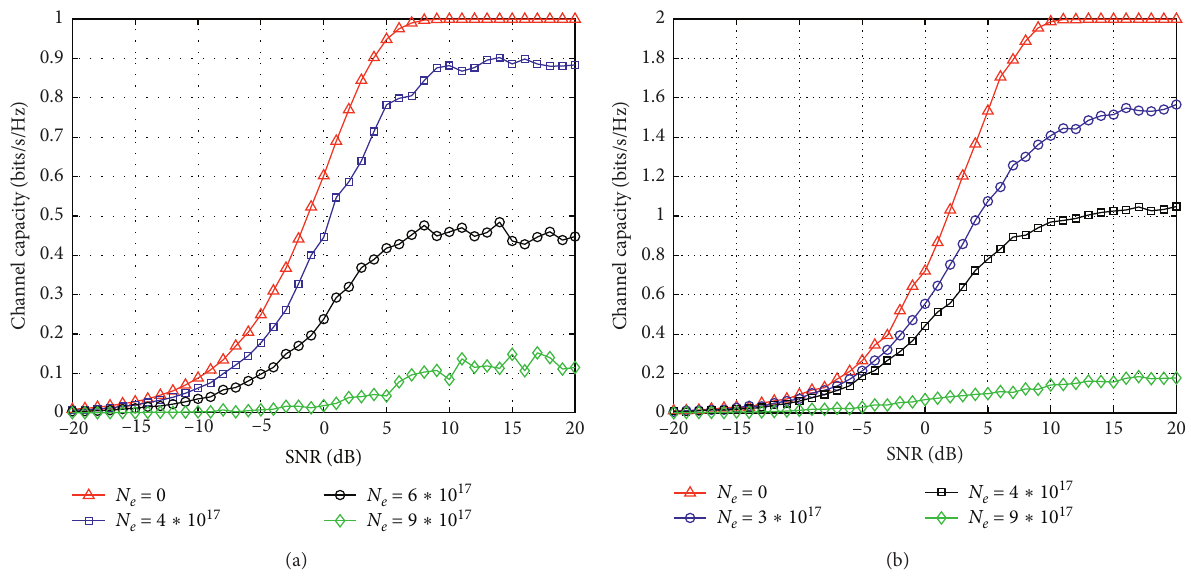
Figure 4: Influence of SNR on channel capacity. (a) BPSK, (b) QPSK.